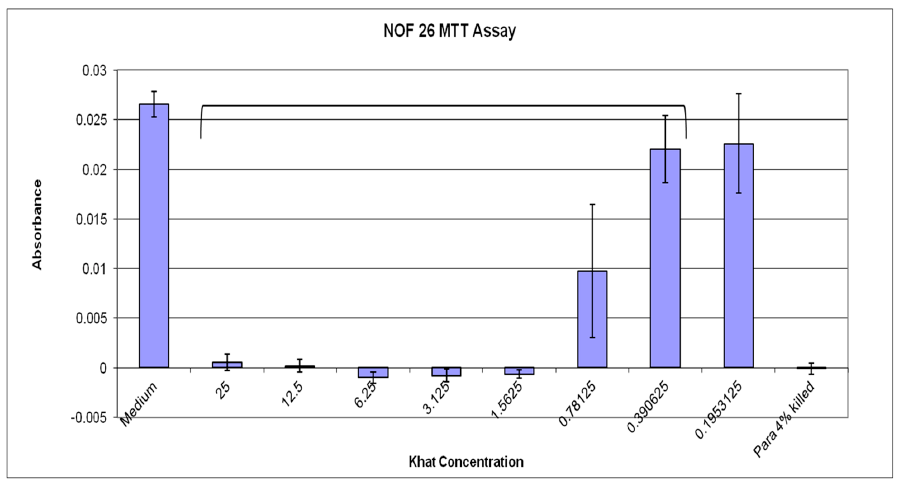
Figure 2. Absorbance from MTT Assay for NOF 26 cells treated with different concentrations of Khat solution (25 mg/mL to 0.195 mg/mL). Medium with only NOF 26 was used as a negative control, while 4% paraformaldehyde was used as a positive control showing complete cell death. NOF 319 cells showed a similar pattern to NOF 26 cells, as all concentrations of Khat caused significant cell death ( p < 0.01). However, cytotoxicity did not appear to be dose-dependent. However, the positive control caused significantly more cell death, as compared to Khat ( p < 0.01) (Figure 3). Figure 3. Absorbance from MTT Assay for NOF 319 cells treated with different concentrations of Khat solution (25 mg/mL to 0.195 mg/mL). Medium with only NOF 319 was used as a negative control, while 4% paraformaldehyde was used as a positive control showing complete cell death. 3.1.4. NOF 18 Exposure of NOF 18 cells to different Khat concentrations resulted in a significant increase in cell death, as compared to the negative control ( p < 0.01). In addition, the ex- tent of cell cytotoxicity was dependent on Khat concentration, showing a dose-dependent response (Figure 4).